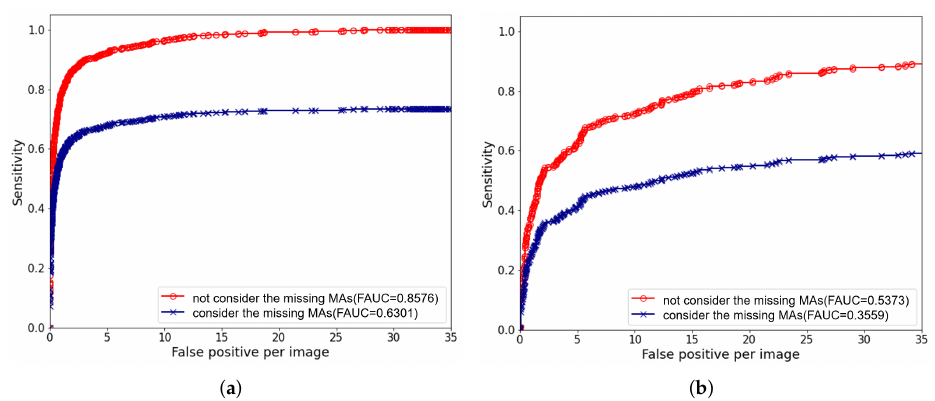
Figure 9. FROC curves of MAs and non-MAs classification. ( a ) The results of the e-optha-MA dataset.